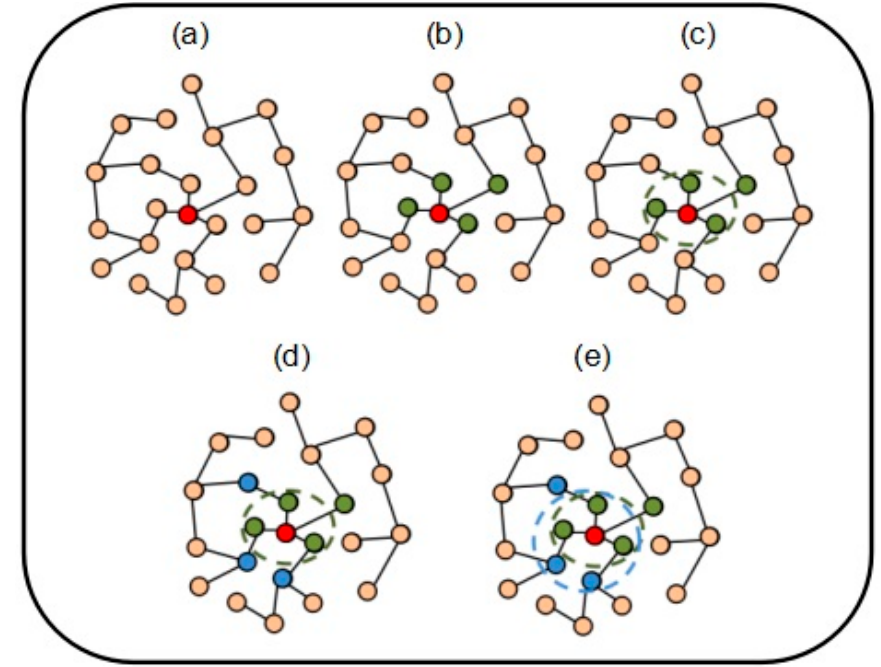
Figure 3. The formation process of a protein complex: ( a ) the red protein represents the seed protein; ( b ) the green proteins represent neighbor proteins of the seed protein; ( c ) these proteins inside the green dotted circle constitute a complex core; ( d ) the blue proteins represent neighbor proteins of the core; ( e ) the proteins inside the blue dotted circle constitute a protein complex.